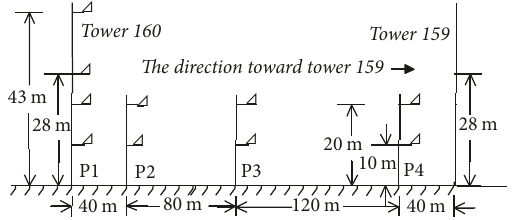
(d) Diagramoftheanemometerinstallationlocations(note:the symbol “ R ” represents a three-dimensional ultrasonic anemom- Figure 5: Arrangements of wind instruments and acceleration sensors in the field.